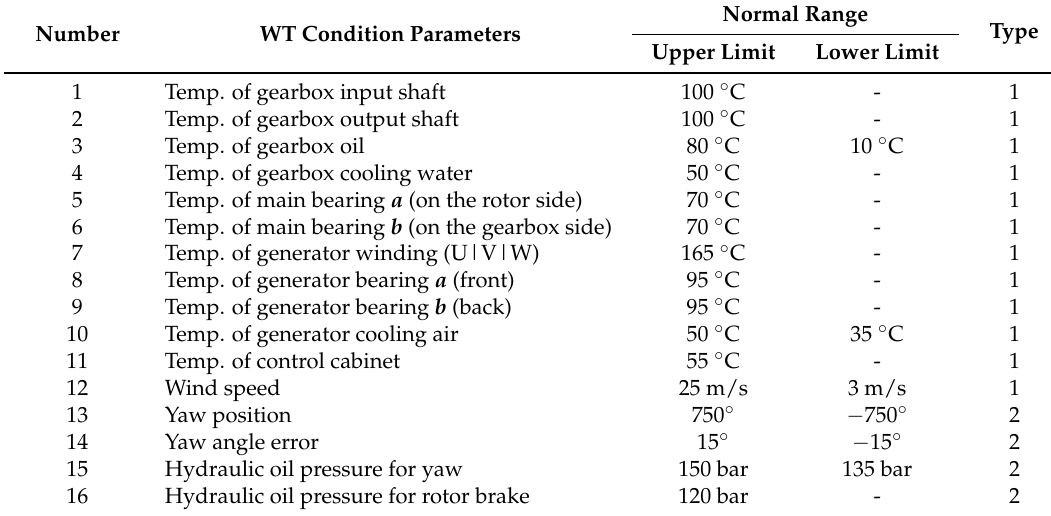
Table 1. Wind turbine (WT) condition parameters studied in this paper. Temp.: